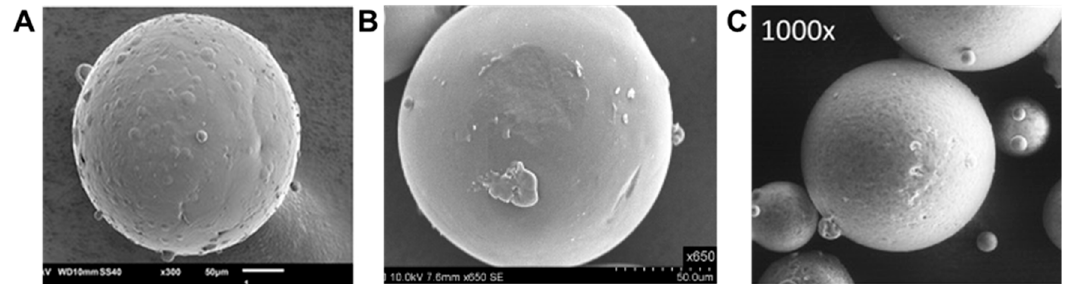
Figure 6. Morphology of spray congealed MPs based on different hydrophilic excipients. ( A ) PEG 3350; ( B ) Poloxamer 407; ( C ) Gelucire 50/13. Figures adapted with permission from [49–51].